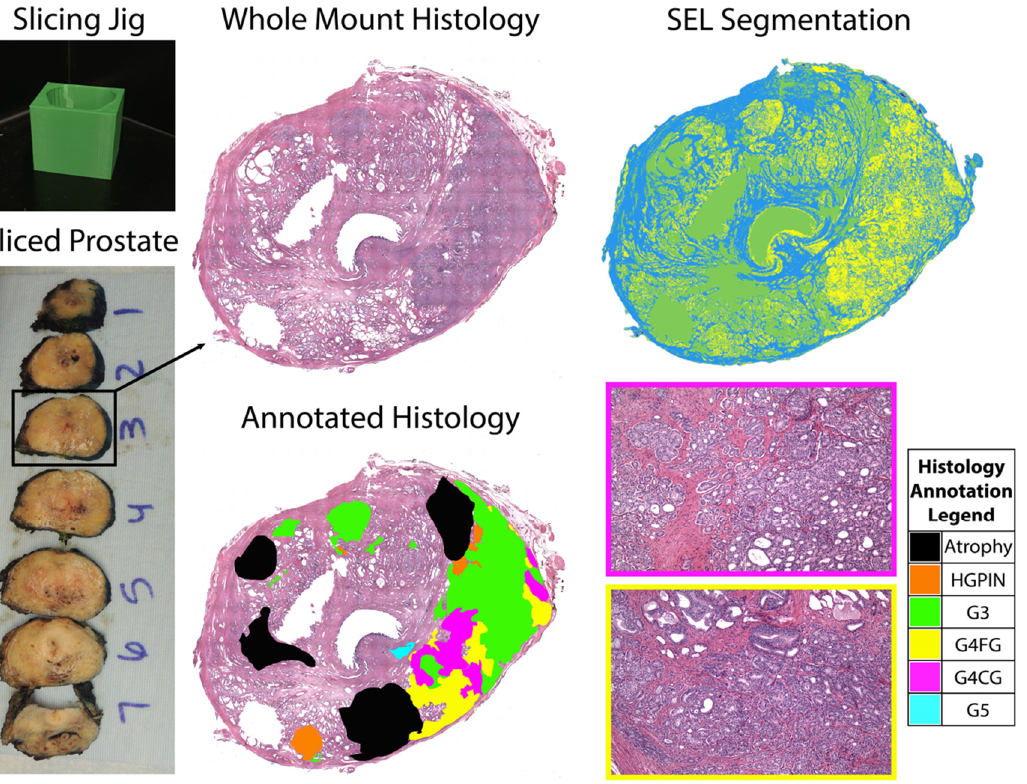
Figure 1. Patient-specific slicing jigs are modeled to match the slice thickness of the T2-weighted image ( left ). The slices are H&E stained, digitized, and annotated for different Gleason patterns ( middle ). Representative tiles from areas of Gleason 4 cribriform glands and fused glands (G4CG and G4FG, respectively) can be seen on the ( right , bottom ). Prostate tissue segmentation (SEL) was performed to create masks for the stroma (blue), epithelium (yellow), and lumen (green) ( top, right ). Multiparametric magnetic resonance imaging (MP-MRI) has shown promise in im- proving the diagnostic accuracy of high-grade prostate cancer [15,16]. Apparent diffusion